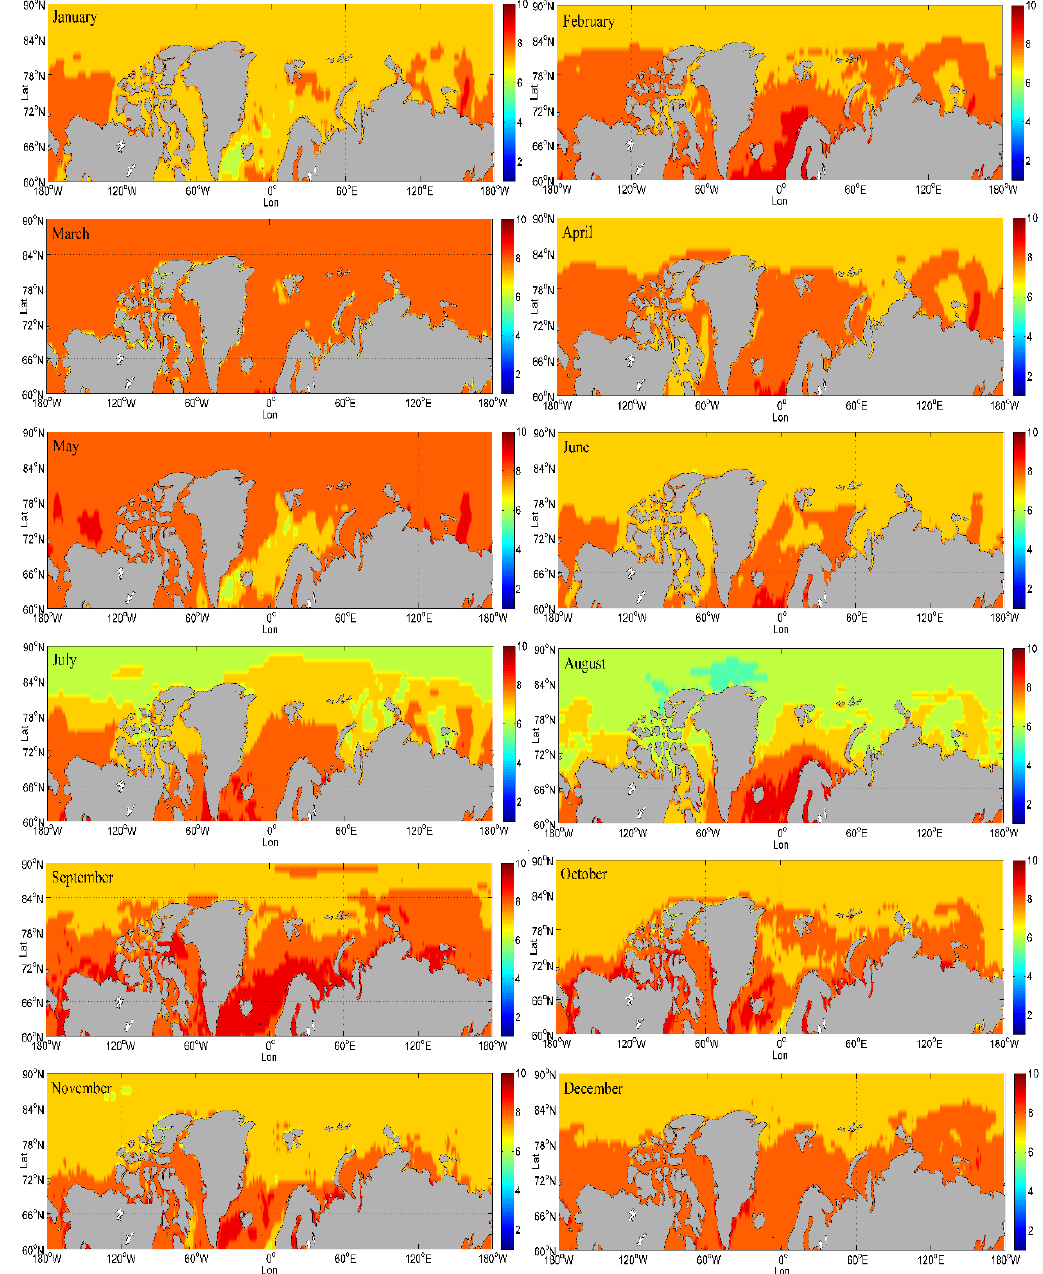
Figure 9. Monthly mean visibility of 10 years, 2009–2018, in the gridded locations of the Arctic.